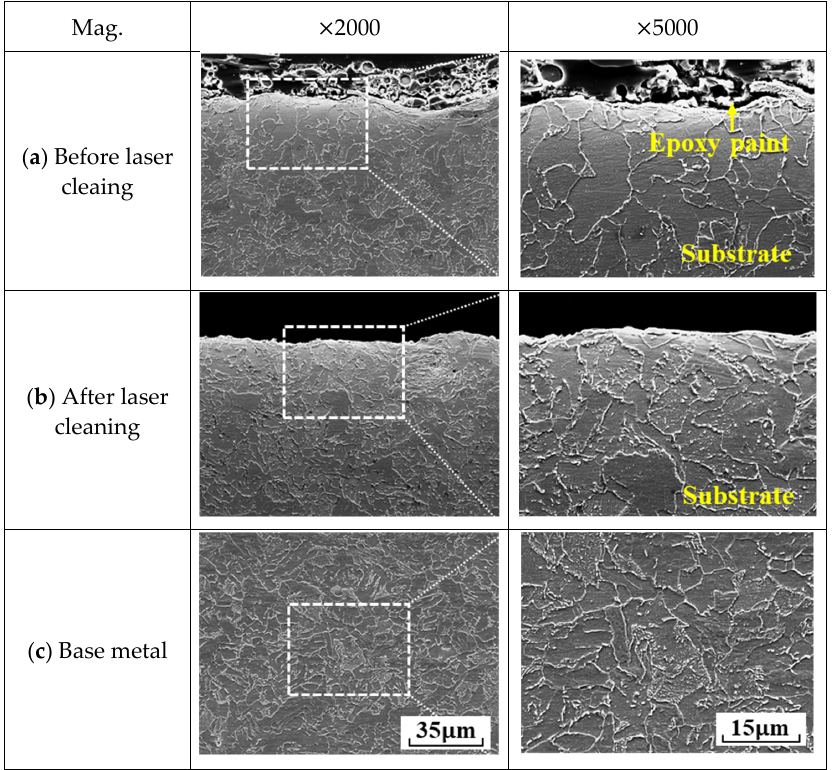
Figure 11. Comparison of microstructure of the laser-cleaned specimen ( a ) before and ( b ) after laser cleaning and ( c ) that of the base